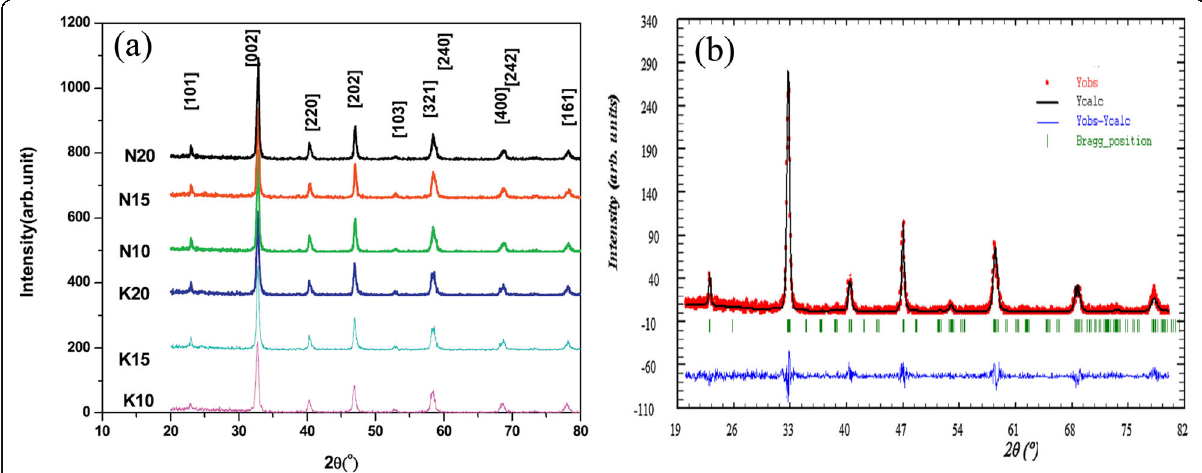
Fig. 8 a Room temperature XRD patterns of La 0.7 Ca 0.3 MnO 3 manganite nanorods synthesized via the hydrothermal method with two mineralizers namely sodium hydroxide (NaOH) and potassium hydroxide (KOH) in different alkalinity conditions (10, 15, and 20 M). b Room temperature XRD pattern (red symbol) and Rietveld profile (black line) for the sample N10. N (or K) means the NaOH (or KOH) mineralizer, 10 for the NaOH (or KOH) concentration. Reproduced with permission of